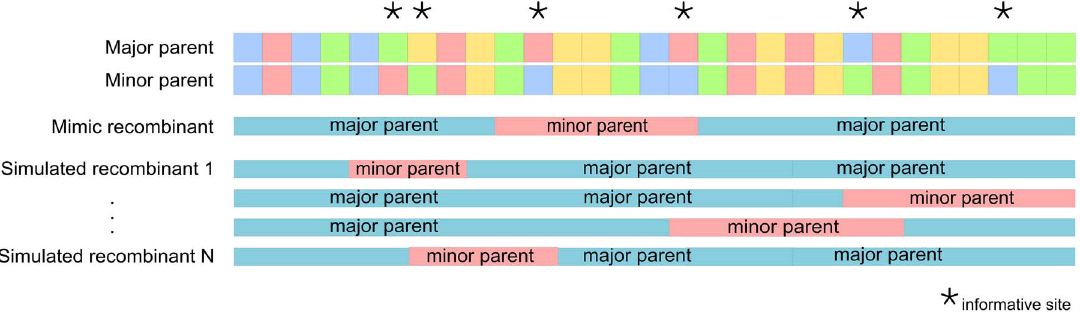
Figure 1. Diagrammatic representation of how simulated recombinants were generated. For a particular recombination event specifying a major parent, a minor parent, and a pair of recombination breakpoint locations delineating a fragment of sequence derived from the minor parent (containing in this particular case two nucleotides that vary between the major and minor parents), an in silico mimic of the real recombinant sequence is created using the minor and the major parent sequences. Following that, a set of N simulated recombinants is generated in a similar way to the mimic recombinant, but using random starting and ending positions, whilst maintaining the same number of either variable nucleotides (for the RNA folding tests) or non-synonymous codon sites (for the protein folding tests) between the randomized breakpoint sites as occur in the mimic recombinant. In this example the mimic and simulated recombinants all have two such ‘‘informative’’ sites between the 3 9 and 5 9 breakpoints that are not identical between the parental